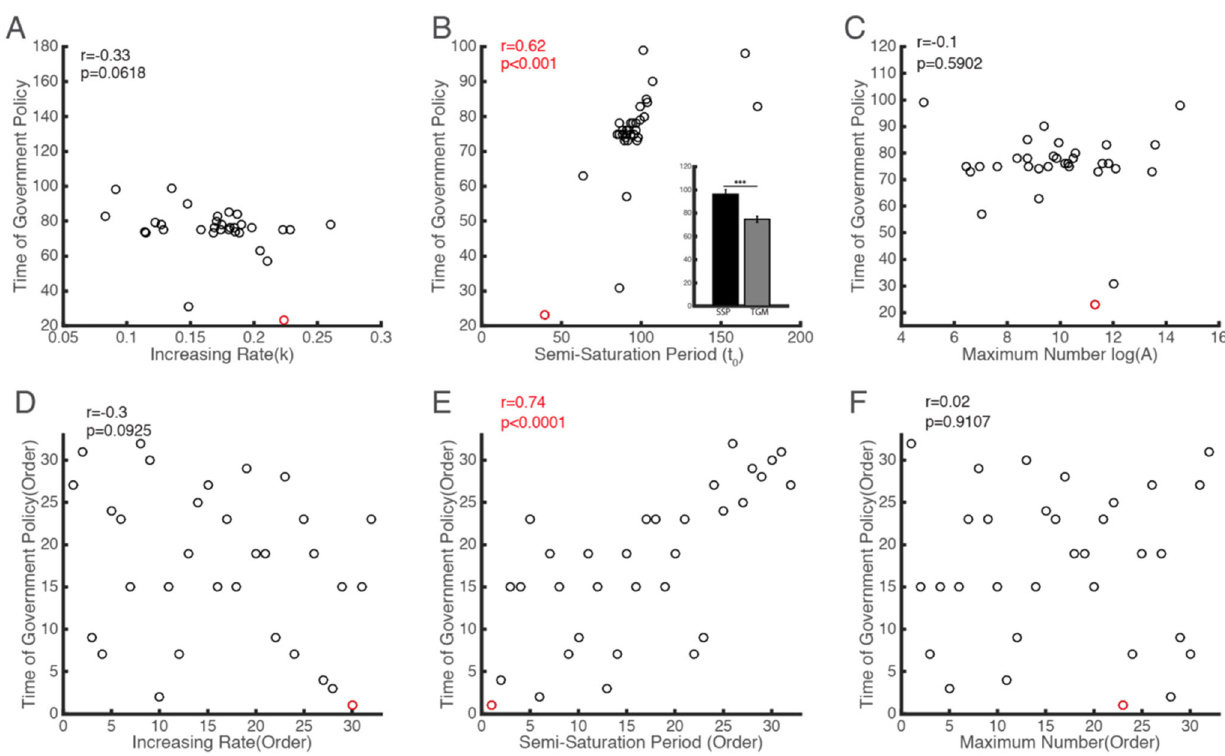
Fig. 9 Relationship between the timing of government intervention and the model parameters of infected COVID-19 cases for each country